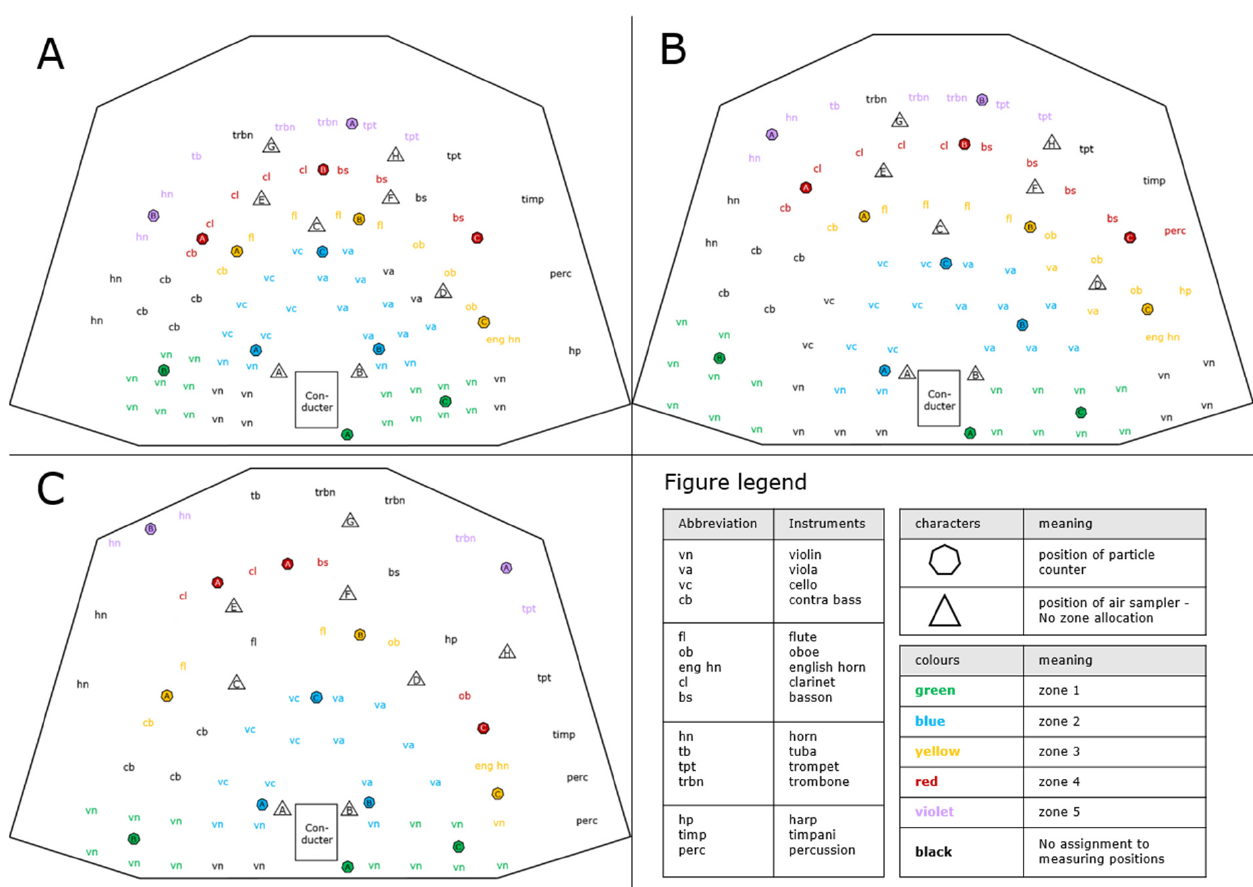
Figure 1. Measurement setup on stage. The different seating positions of the musicians in the narrow ( A ), medium ( B ) and wide ( C ) arrangements are shown. The abbreviations represent the different instruments (see legend). The positions of particle counters and air samplers are displayed by a hexagon and a triangle, respectively. Furthermore, for comparison and interpretation of results, the measuring positions of particle counting were assigned to zones, which is indicated by the different colorings of the devices.